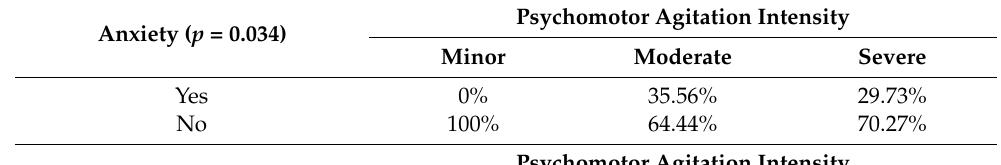
Table 4. Predictive variables (frequencies and